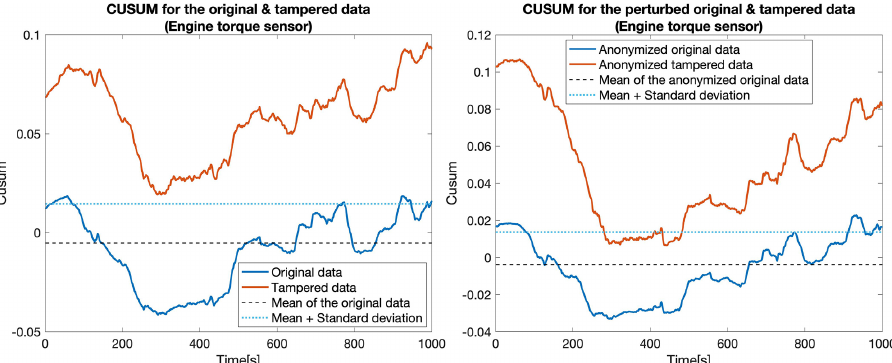
Figure 9. CUSUM for the original data (blue) and tampered data (orange) for the Engine torque